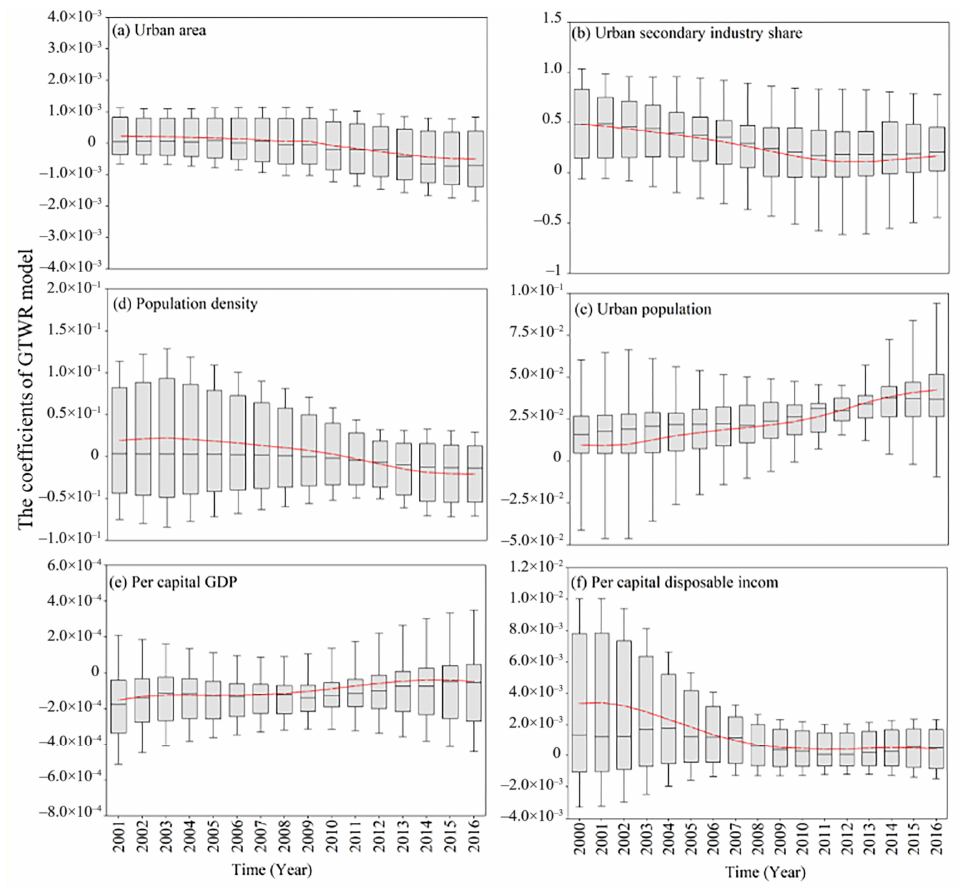
Figure 7. Temporal distribution of estimated coefficients of GTWR model. The red line represents the variation trend of the average coefficient of the GTWR Updated Figure 7. .(clear version)